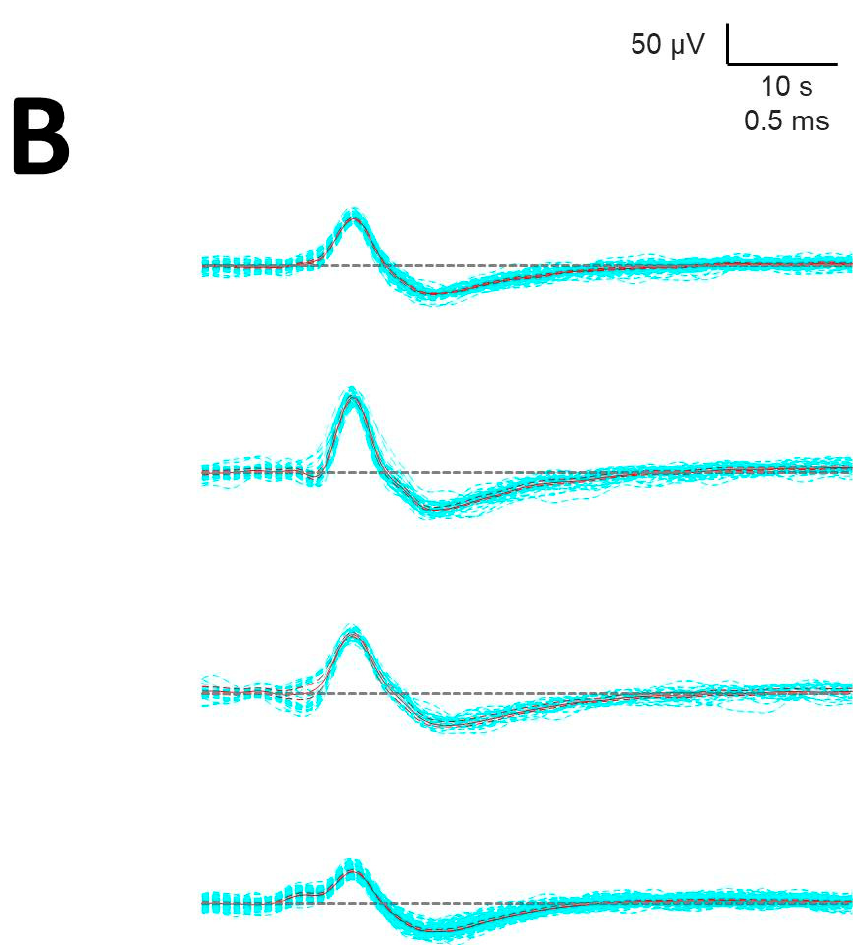
Figure A2. Sorting of spikes ( A ) Raw recording. ( B ) Units obtained from that trace. Blue: individual AP, continuous red = mean of all AP (mA), discontinuous red = upper/lower limits, dashed horizontal: basal level.